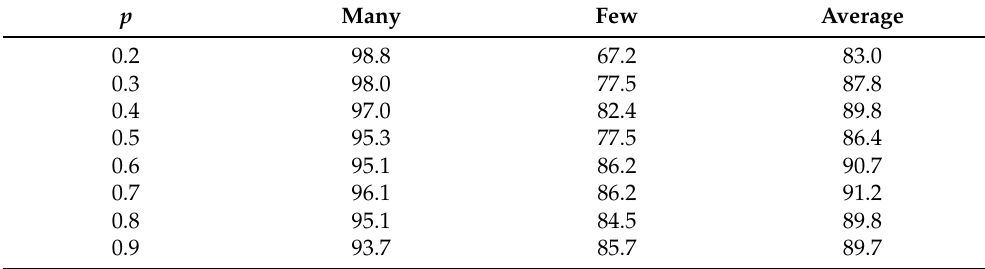
Table 8. Ablation results involving the hyper-parameter p in the loss function of the mitigation factor.